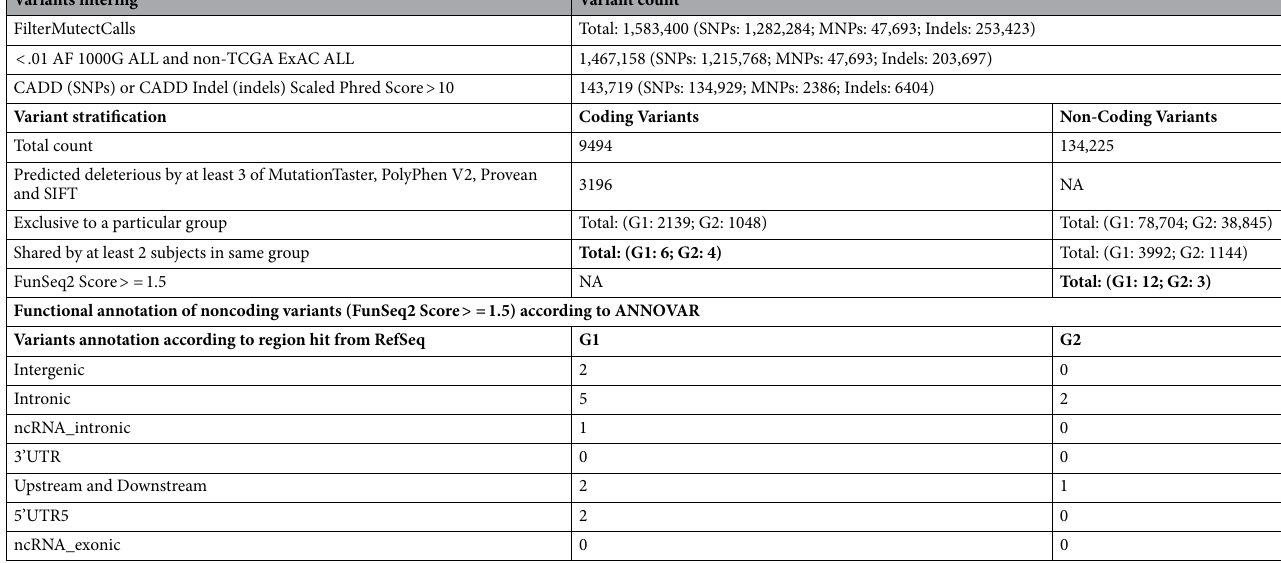
Table 4. Variants count with functional annotation of noncoding variants. Bold indicates final variant count after filtering. RefSeq Reference sequence database, ncRNA non-coding transcript variant, NA Not Applicable, ExAC Exome aggregation consortium, AF Allele Frequency, 1000G 1000 Genomes project for all individuals in this release, CADD Combined Annotation Dependent Depletion, SNPs Single Nucleotide Polymorphisms, Indels insertions/deletions, MNPS Multi-nucleotide Polymorphisms, PolyPhen V2 PolyPhen Version 2, G1 positive-positive subjects, G2 positive–negative subjects, SIFT Sorting Intolerant From Tolerant, PROVEAN Protein Variation Effect